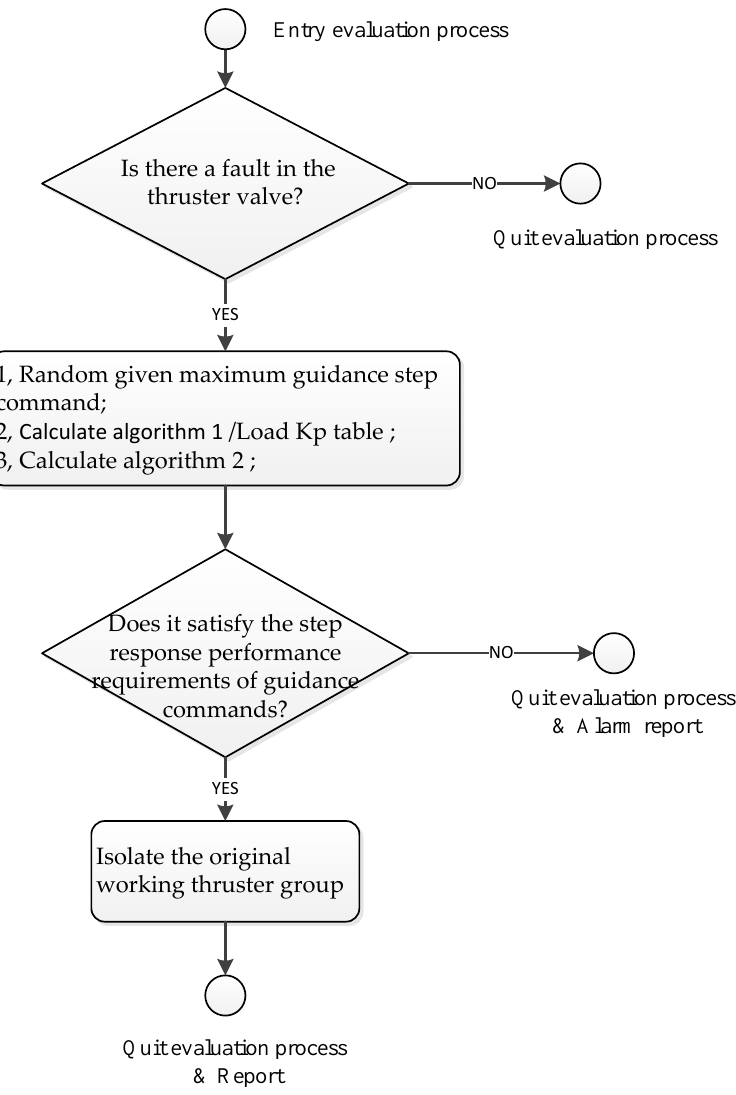
Figure 6. Thruster control recovery evaluation based on fault detection.